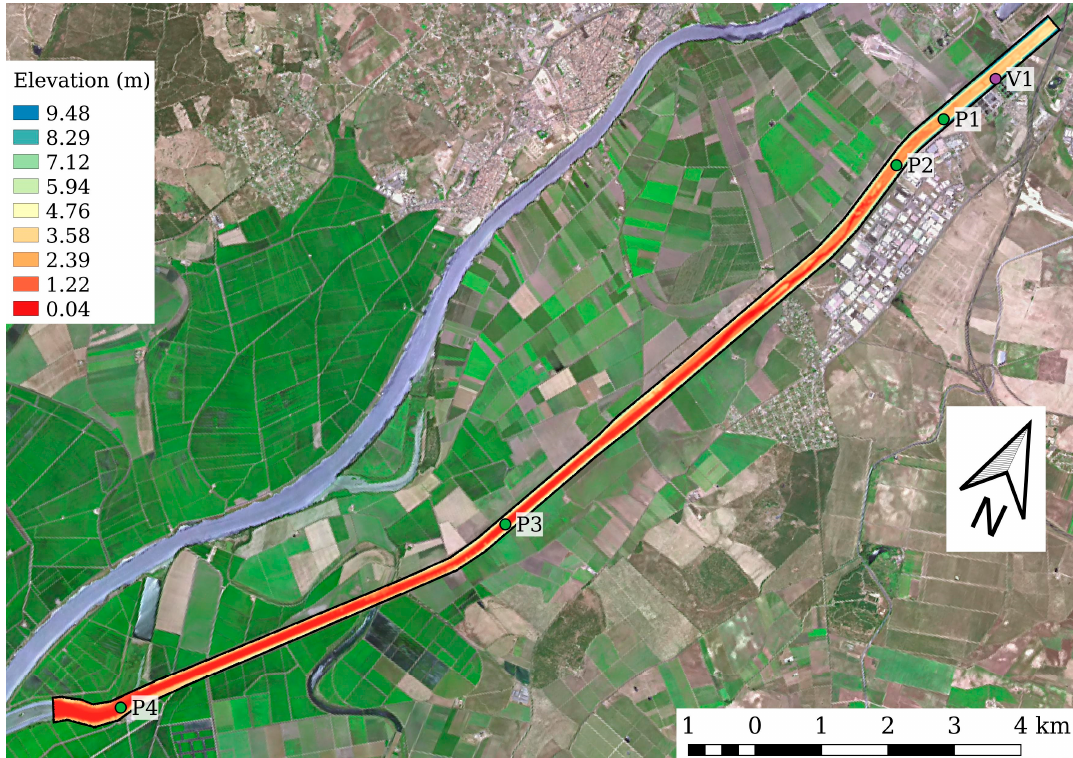
Figure 11. Bathymetry of the river reach in Test Case 4. The sewage spill of the Wastewater Treatment Plant (WWTP) is located at point V1. Control points are located at P1, P2, P3 and P4.